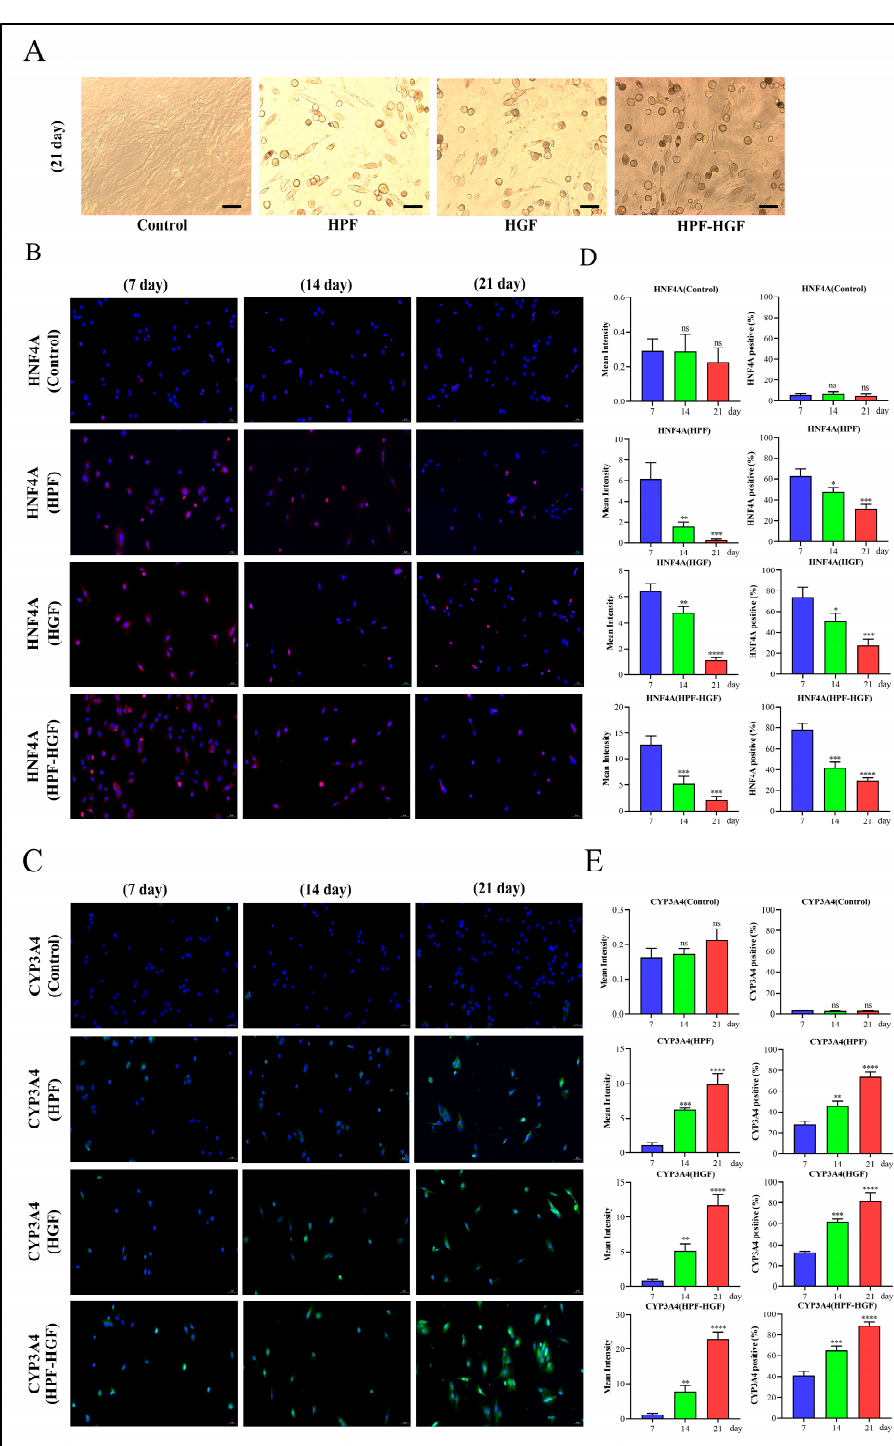
Figure 3. Inducing BMSCs to differentiate into HLCs. ( A ) Morphological observation of the differentiation of BMSCs into HLCs, stimulated by HPF, HGF and HPF–HGF for 21 days (200 × magnification). ( B , C ) The expression of the hepatocyte markers HNF4A and CYP3A4 in HPF-, HGF- and HPF– HGF-treated BMSCs, as well as in untreated BMSCs, was detected by immunofluorescence staining (HNF4A in red, CYP3A4 in green, DAPI-stained nuclei in blue) (200 × magnification). ( D , E ) The immunofluorescence staining results of HNF4A and CYP3A4 were analyzed by mean fluorescence intensity and positive rate. * p < 0.05, ** p < 0.01, *** p < 0.001, **** p < 0.0001 and ns (no statistical significance), compared with the group treated for 7